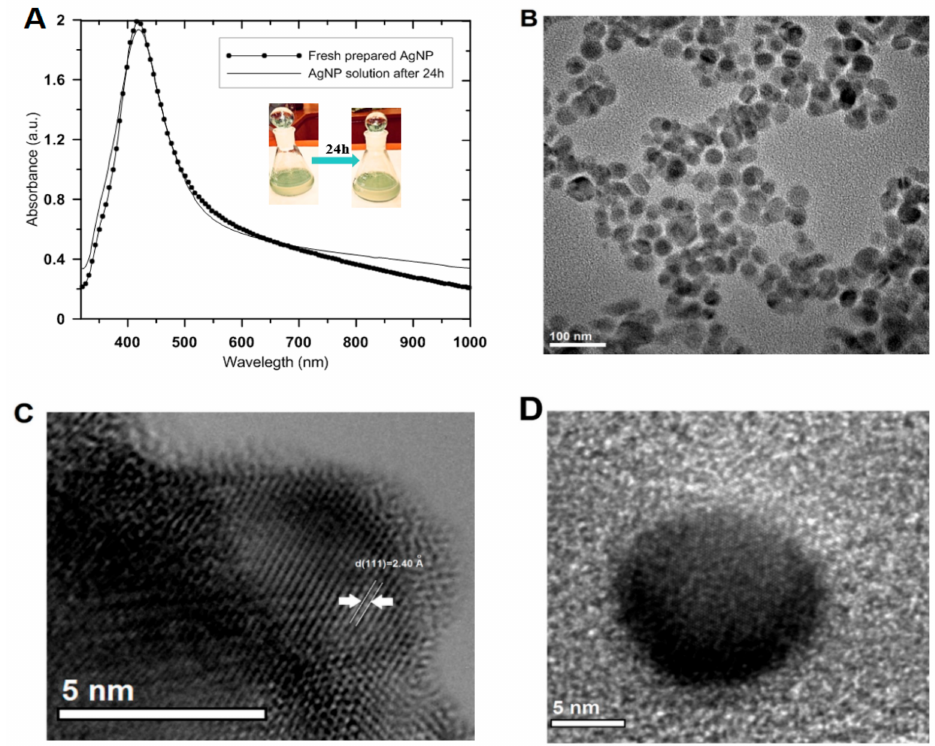
Figure 1. ( A ) UV-Vis absorption spectra of silver nanoparticle colloidal solutions (freshly prepared and after storage for 24 h) and digital photos of experimental probes of AgNP. ( B ) Transmission electron microscope images of the colloidal silver solution. ( C , D ) High-resolution TEM images of silver nanocrystals. Note: The concentration of the colloidal silver solution was adjusted by dilution in distilled water for the best visibility in the UV-Vis spectrum (maximum absorbance